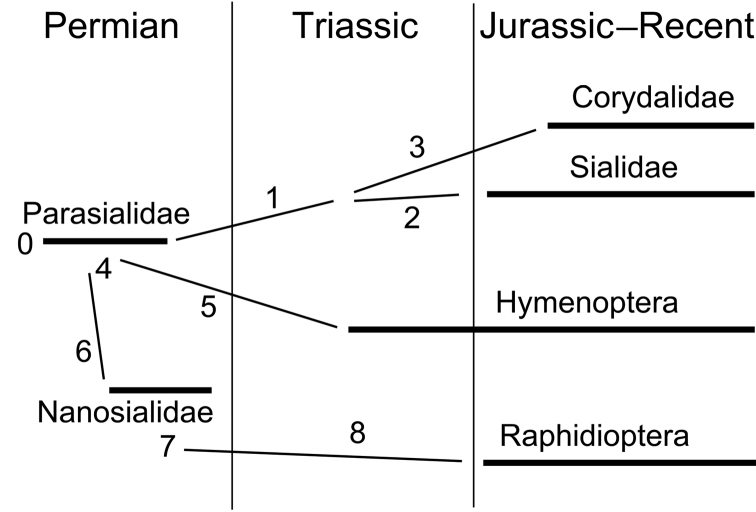
Phylogenetic diagram of Panmegaloptera and Hymenoptera (for characters see Appendix).